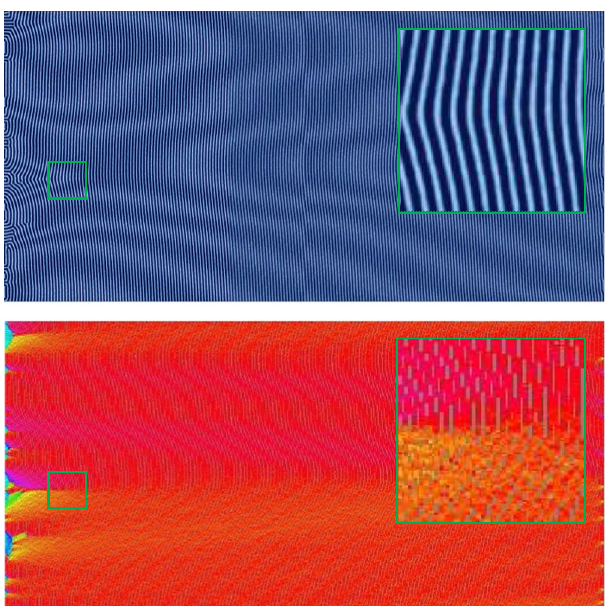
Figure 5. Same as Fig. 3 with a zone velocity of v zone = 0.2301. A predominately perpendicular alignment has formed with the minor exception of the left boundary where the thermal zone enters the